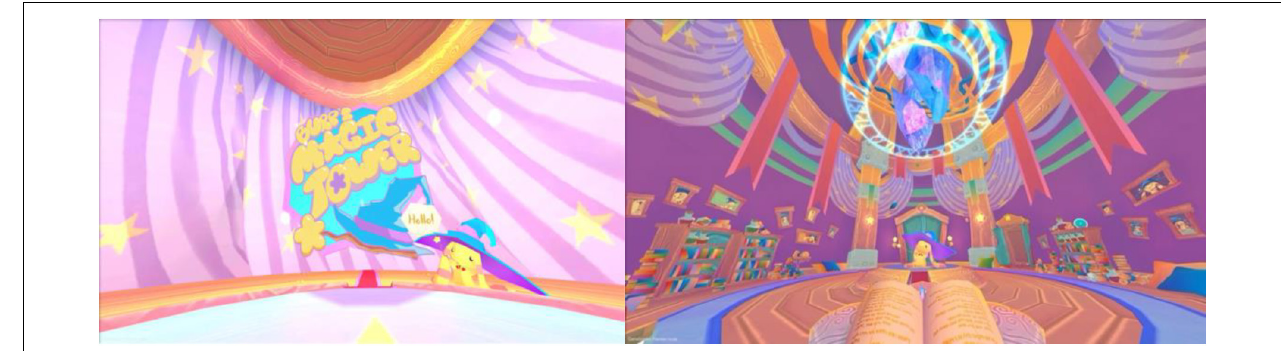
FIGURE 1 | The Burp’s Magical Tower depicted the SILVER software.